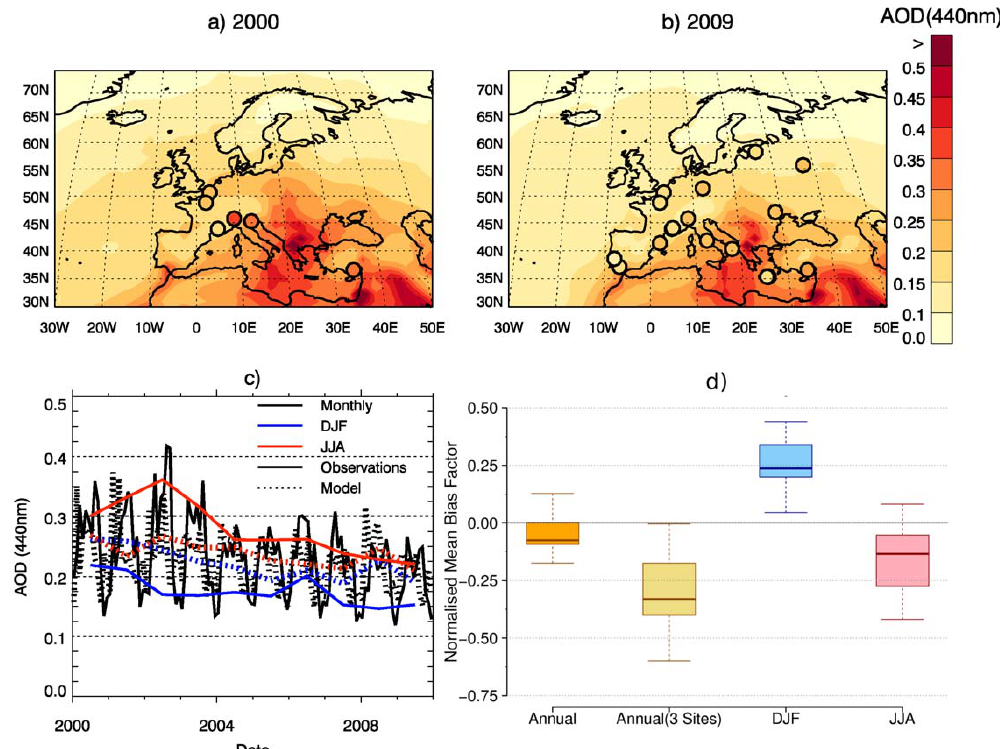
Figure 12. Annual mean AOD at 440nm with observations from the AERONET sites overplotted for (a) 2000 and (b) 2009. (c) Time series of monthly and seasonal mean observed (solid lines) and modelled (dashed lines) AOD at 440nm averaged across all measurement locations. (d) European NMBFs of AOD for annual (orange), summertime (red) and wintertime (blue) across all the years and sites that data were available. The annual NMBF for the three sites with the longest continuous record ( > 9 years) is shown in